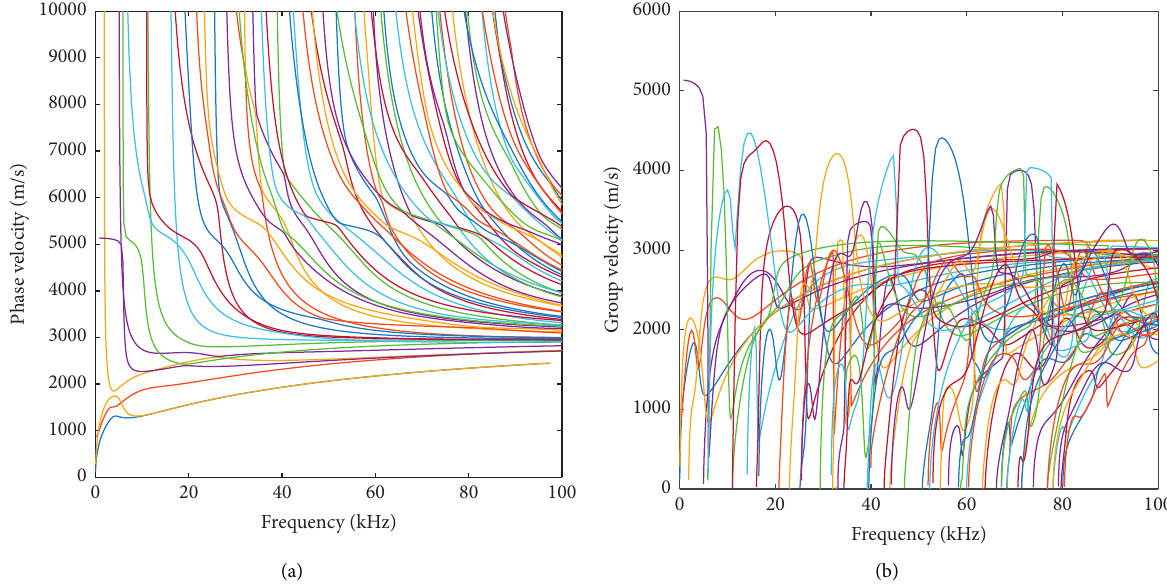
Figure 3: Dispersion curves for rail 56E1: (a) phase velocity and (b) group velocity.